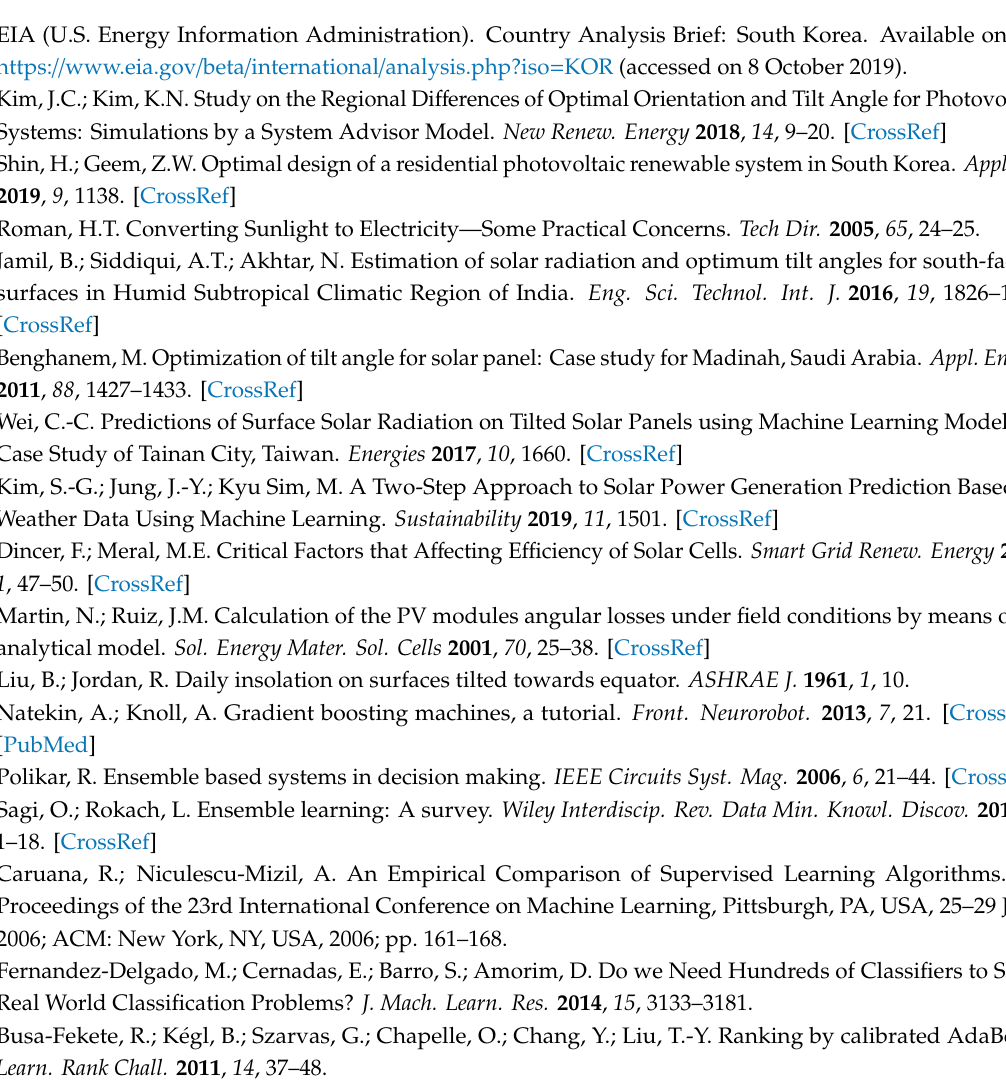
Figure A4. Monthly tilt angles and outputs of S13-04 module.